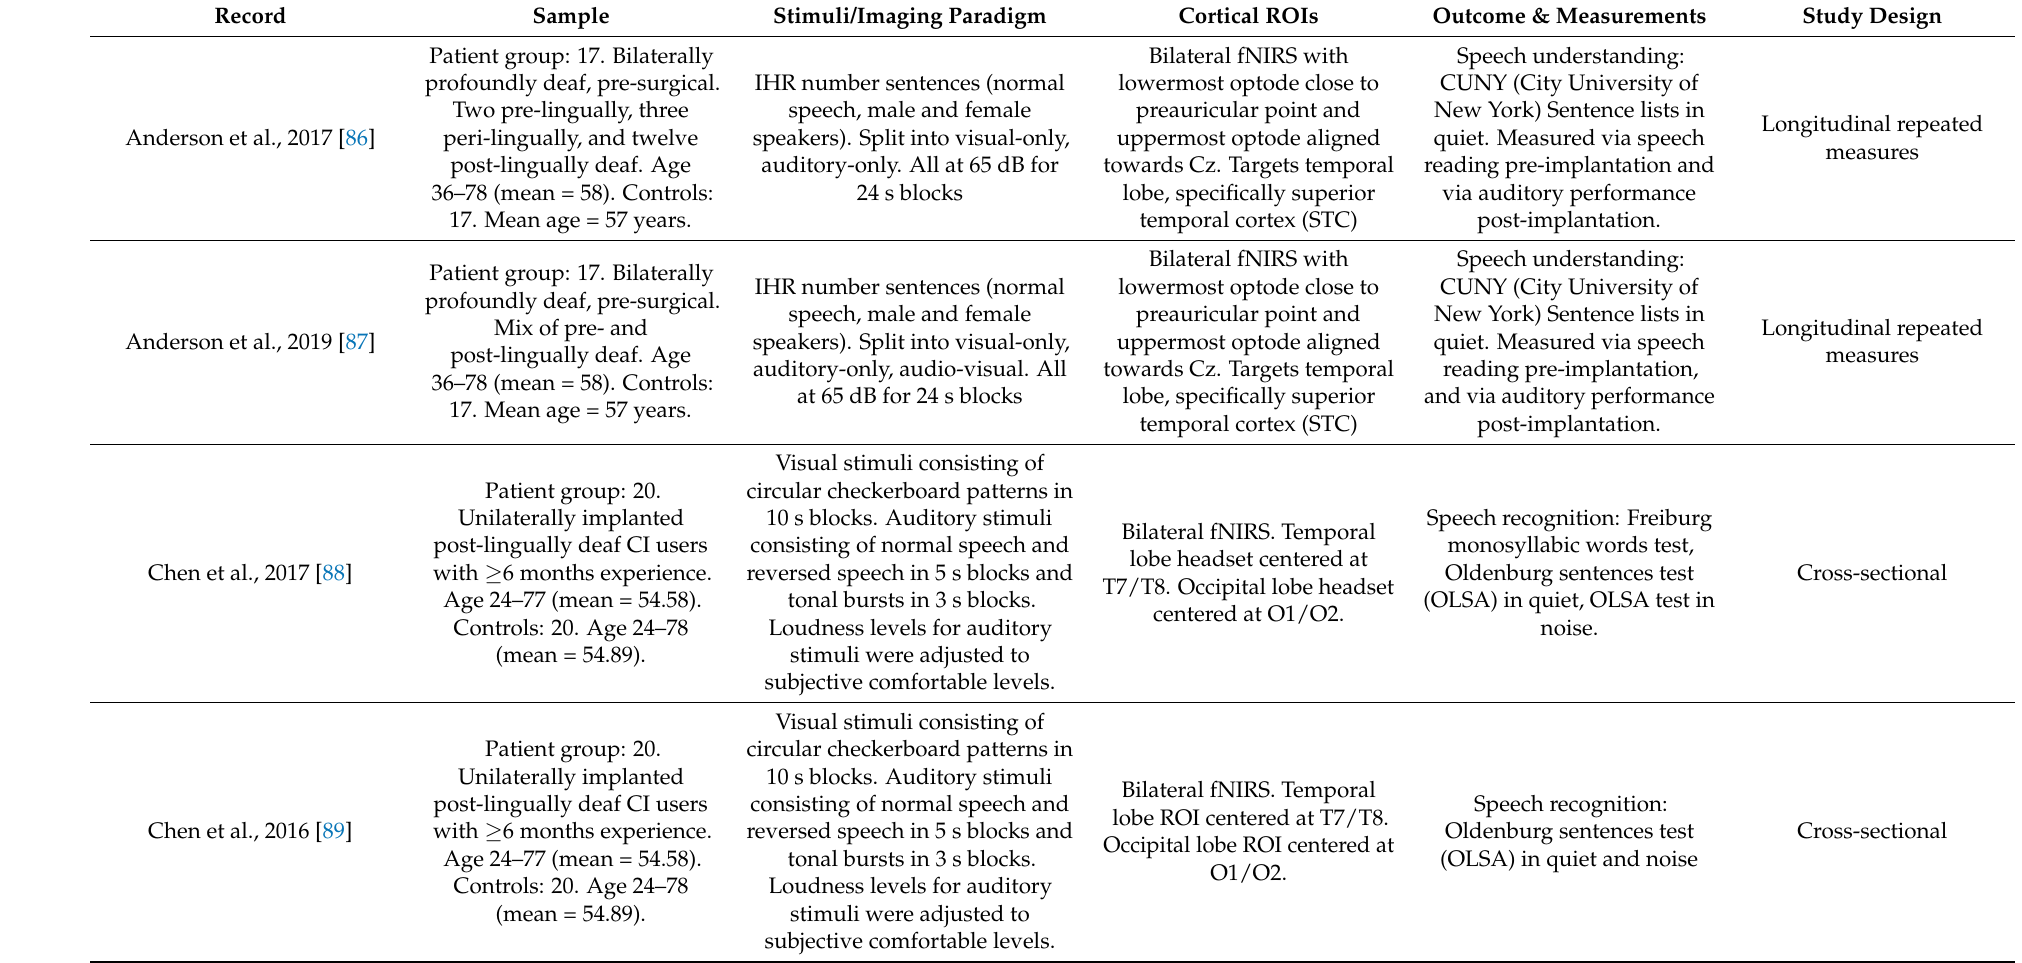
Table 1. Sampling and design information from the eight included